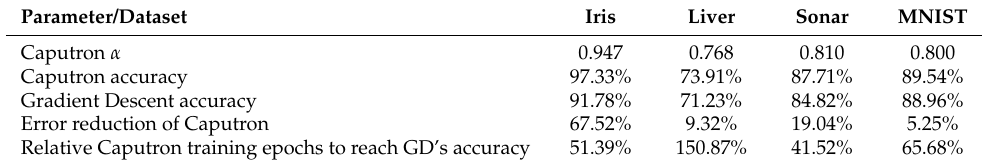
Table 1. Comparison of Gradient Descent and Caputron including the best fractional derivative orders for each dataset with the classification error reduction induced by replacing Gradient Descent with Caputron, and the percentage of epochs taken to reach Gradient Descent’s accuracy by Caputron (with Gradient Descent training epochs being